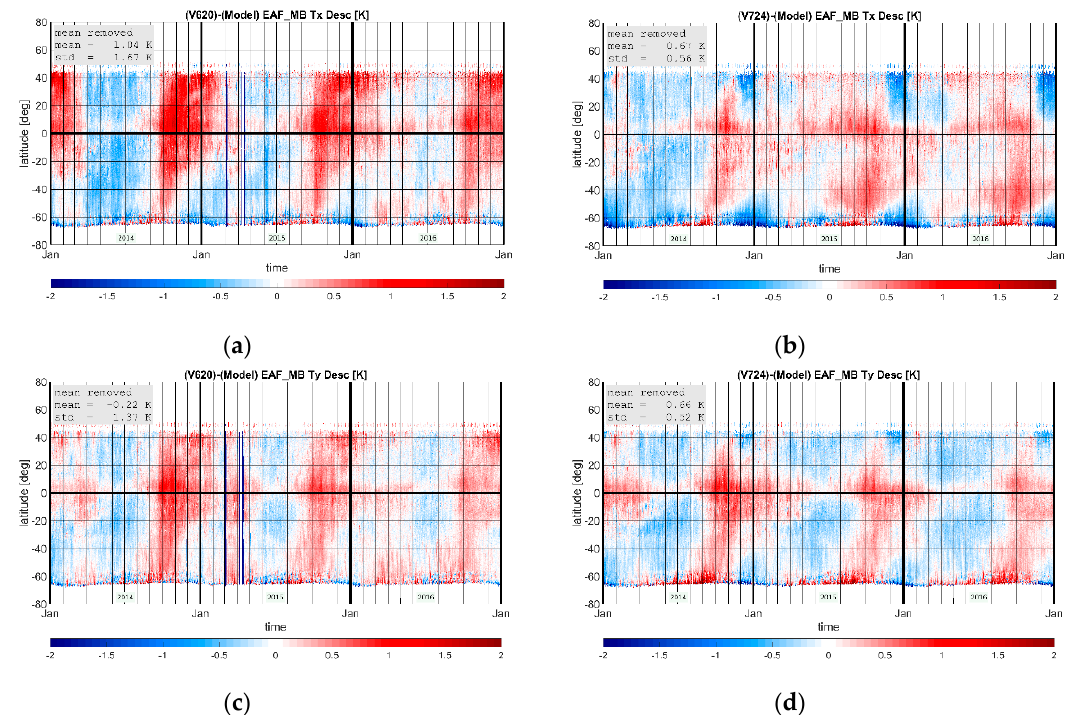
Figure 15. Hovmoller plots showing the bias between measurement and model averaged over the entire extended alias-free field of view for descending orbits for ( a ) v620 X polarization, ( b ) v724 X polarization, ( c ) v620 Y polarization and ( d ) v724 Y polarization.